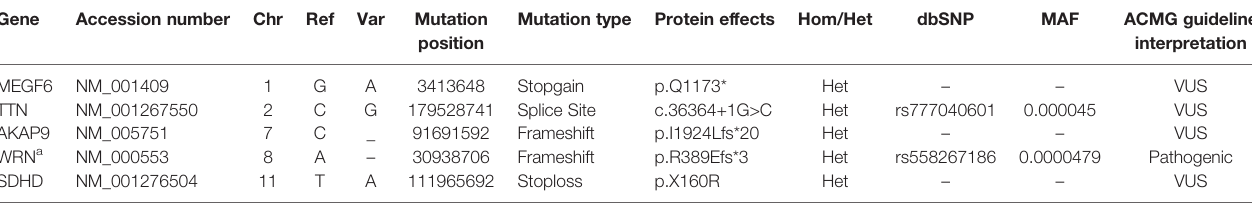
TABLE 1 | Truncating heterozygous variants (i.e., putative frameshifts, stopgain, nonsense mutations) in candidate CRC predisposing